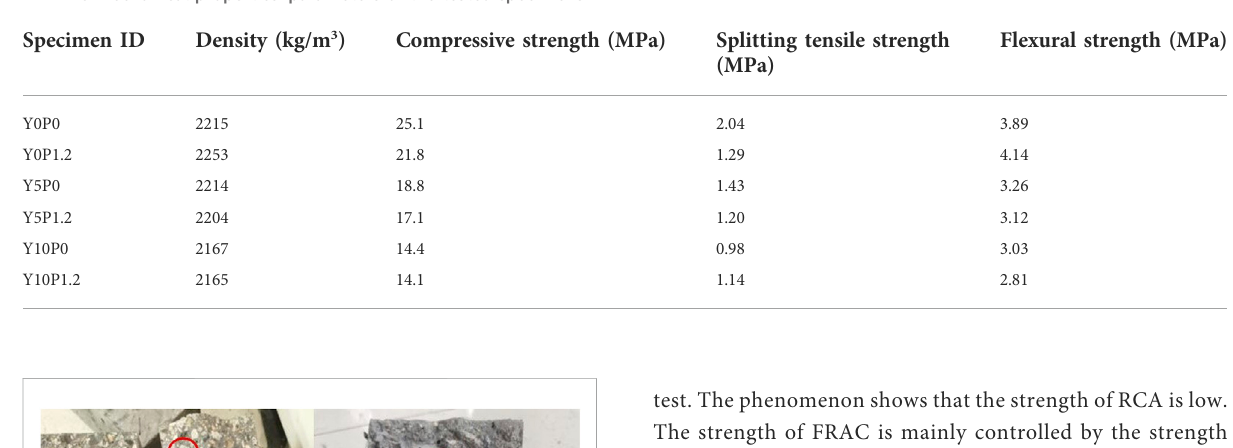
TABLE 3 Mechanical properties ’ parameters of the tested